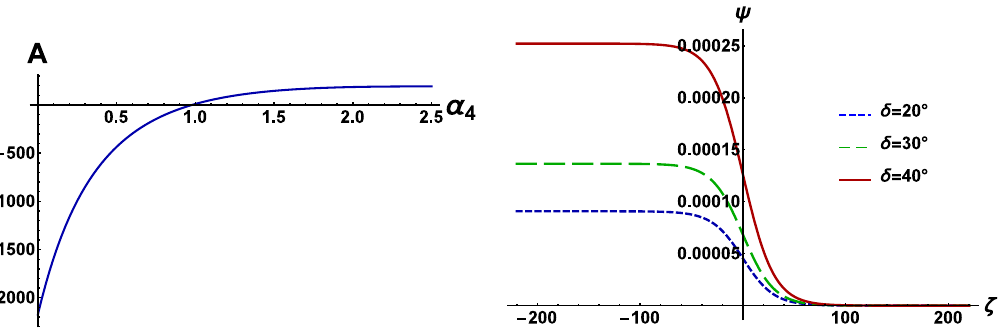
Figure 1. The variation of nonlinear coefficient A with α 4 ( left panel ) and Ψ with ζ for different values of δ ( right panel ) along with α 1 = 1.5, α 2 = 0.05, α 3 = 0.03, λ p = 1.5, λ e = 1.7, λ d = 0.05, α = 0.5, and V p ≡ V p +